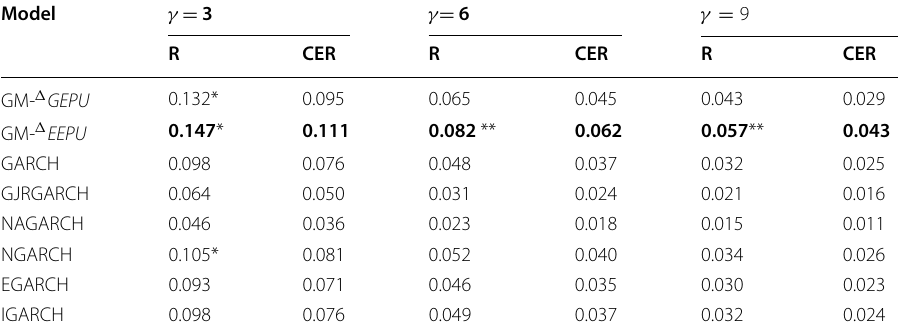
R is the mean excess returns and CER denotes the certainty equivalent returns. ∗∗ , ∗ indicate significance at the 5% and 10% levels, respectively, under the t‑statistics test. All values were based on days multiplied by 100. Bold numbers represent the largest values for each